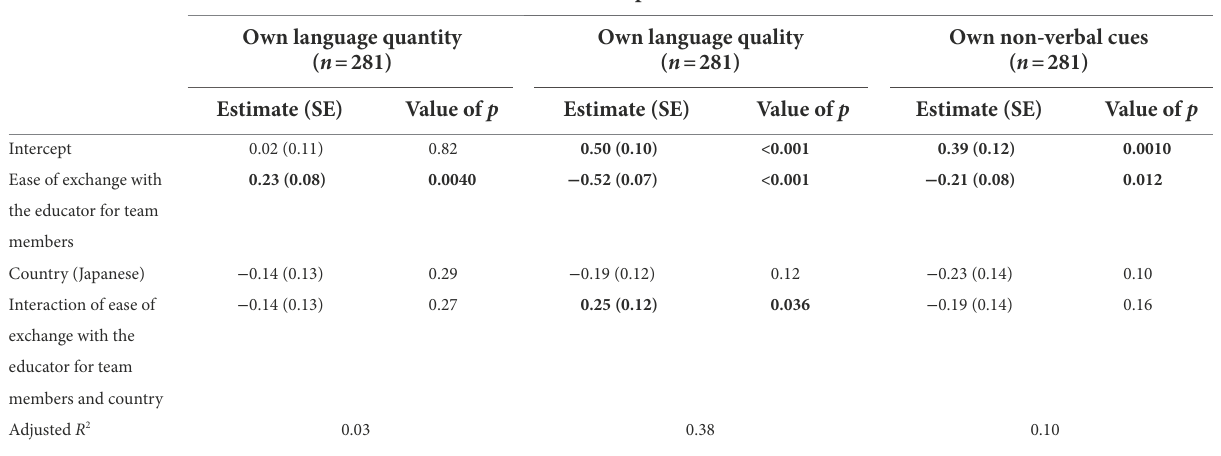
TABLE 11 The linear regression models predicting educators’ own communicative behavior toward team